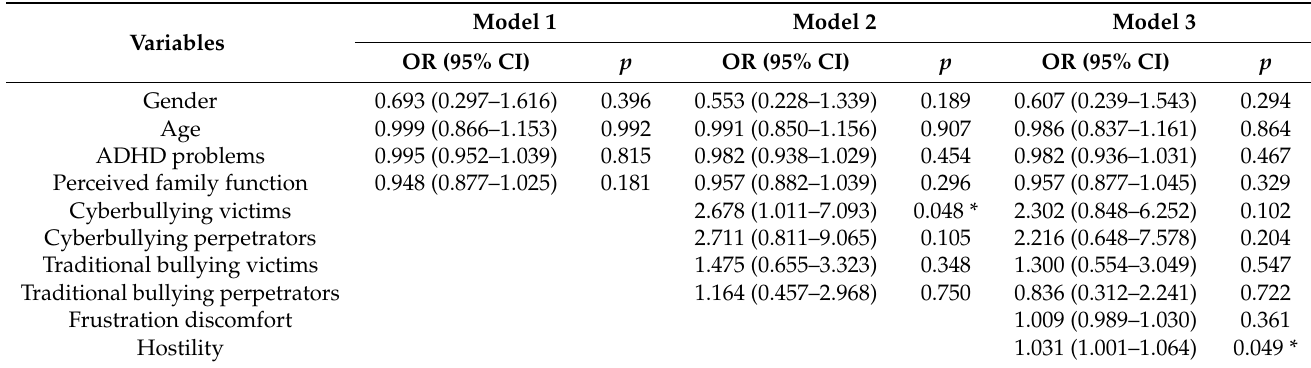
Table 3. Factors related to suicidality: logistic regression